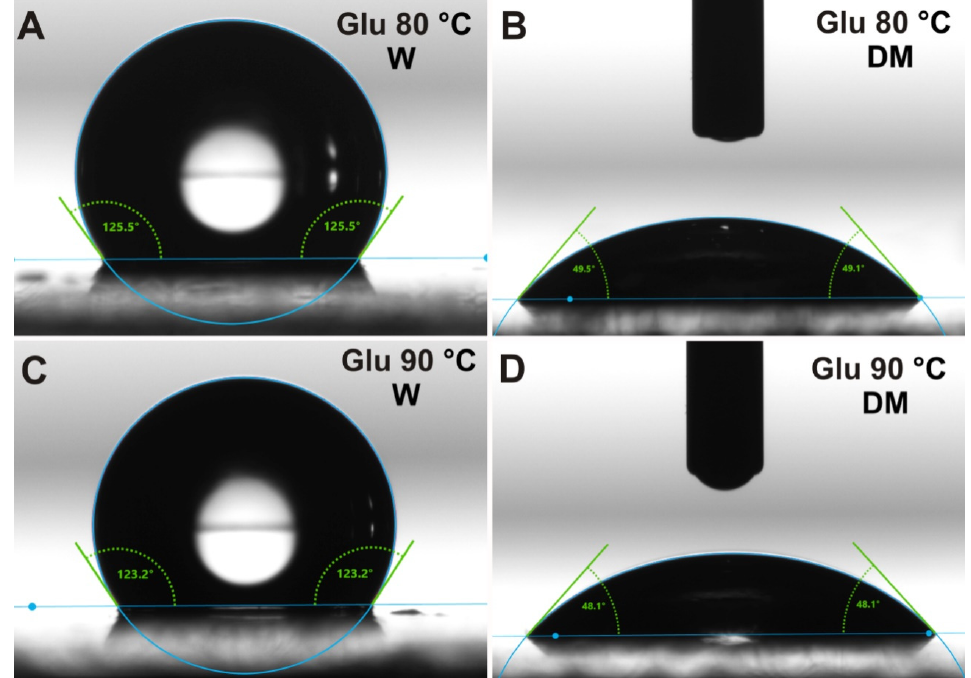
Figure 7. Images presenting water (W) ( A , C ) and diiodomethane (DM) ( B , D ) contact angle measurements for glucan matrices gelled at 80 °C ( A , B ) and 90 °C ( C , D